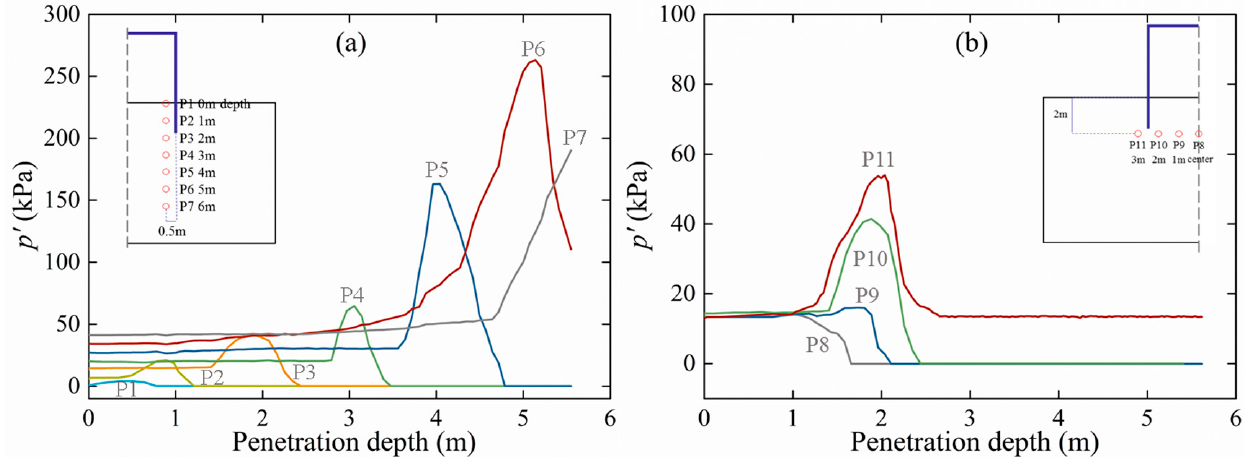
Figure 11. Mean effective stress evolution with caisson suction penetration depth at typical points within the soil: ( a ) Points P1 to P7; ( b ) Points P8 to P11.